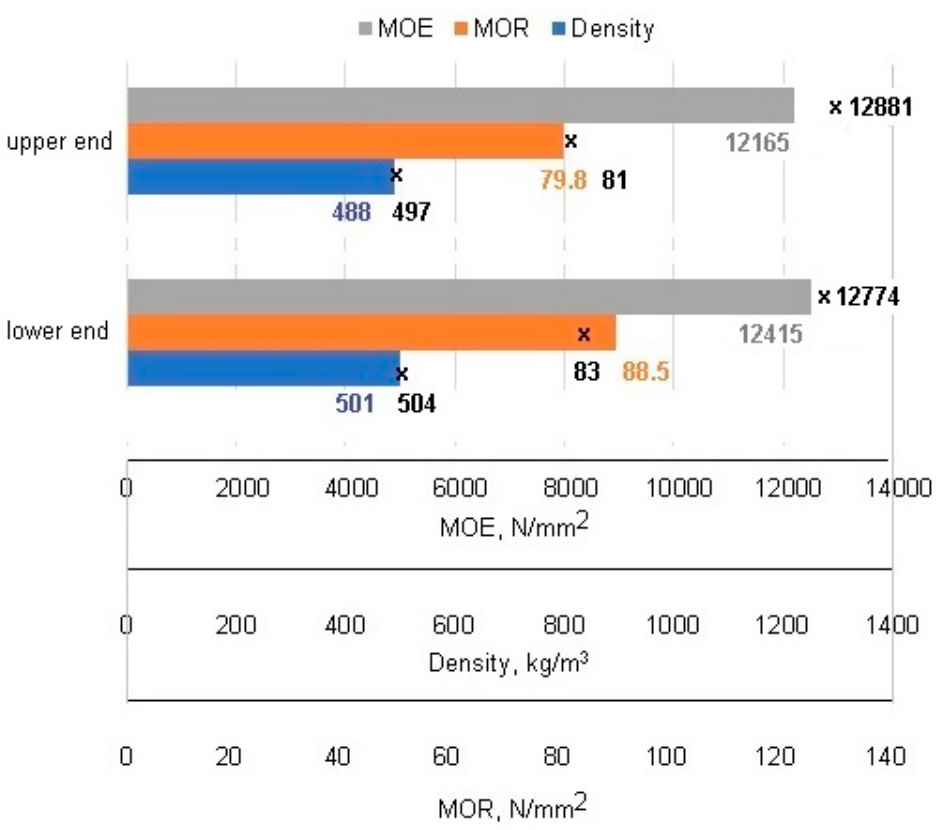
Figure 8. Variation tendency of density, MOE and MOR, over the log height for the solid wood samples (represented with the colored columns), compared to glued samples (represented with “x”).